Question: Does the figure show an increasing or a decreasing trend?
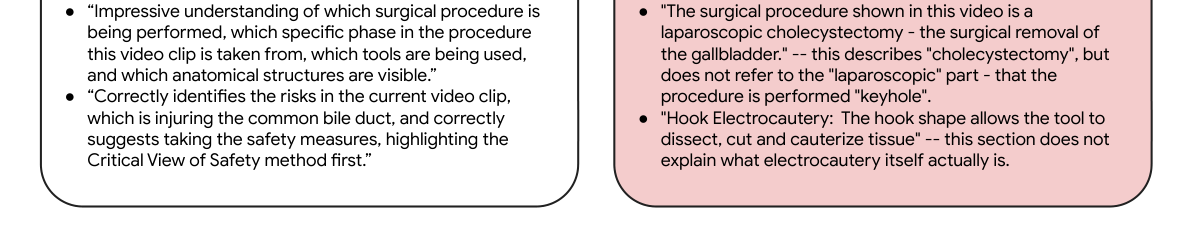
Answer: increasing